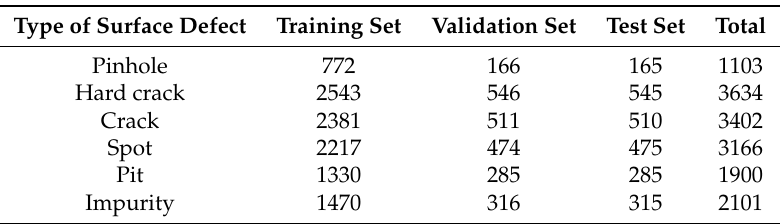
Table 2. Defect type statistics for each